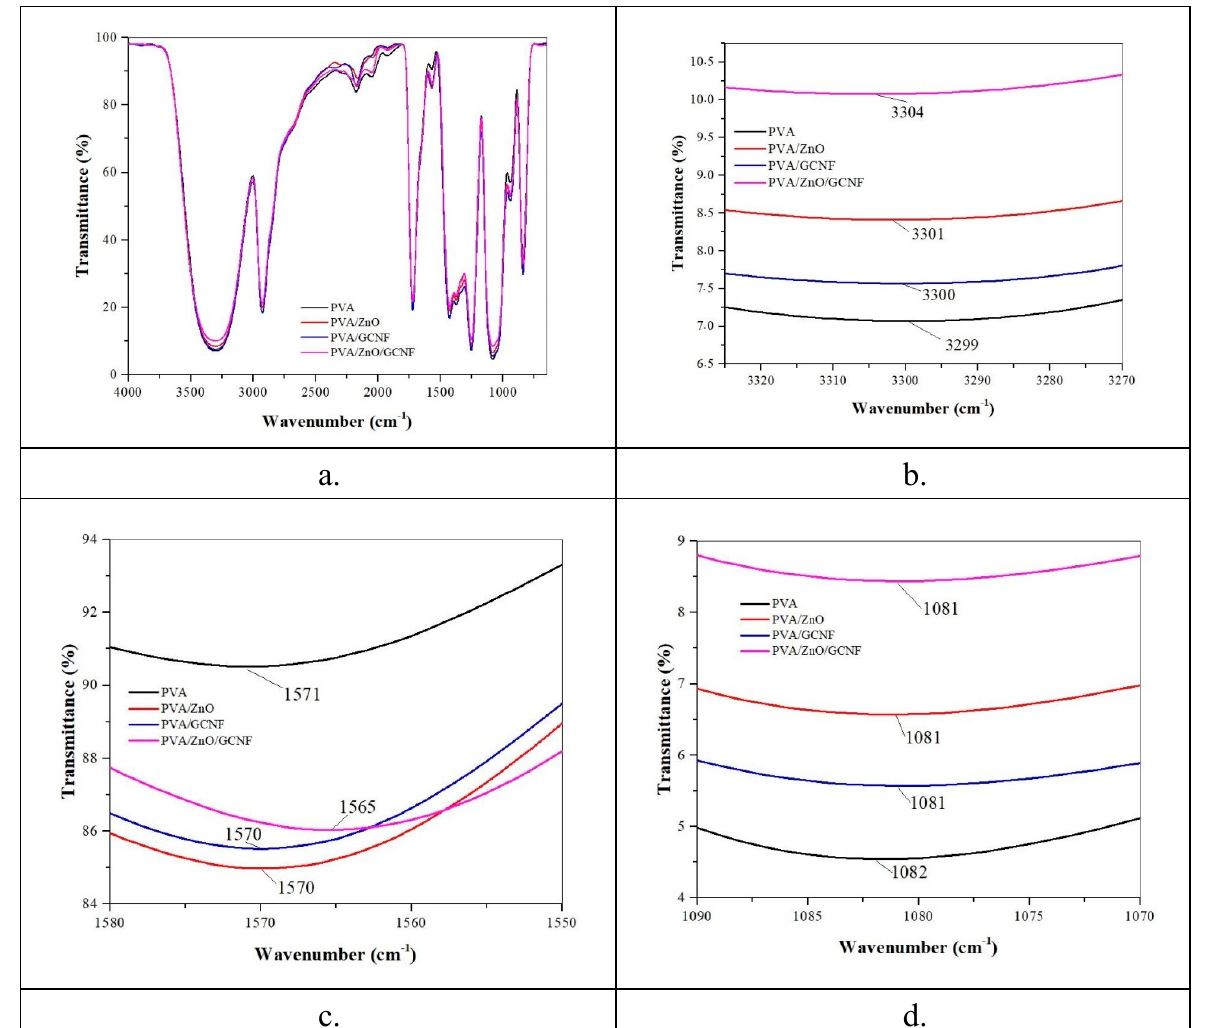
Figure 2. ( a ) FTIR spectra for all the characteristic peaks of pure PVA and the biocomposite films, ( b ), O–H stretching band, ( c ) N-H bending band, and ( d ) C-O stretching vibrations band.